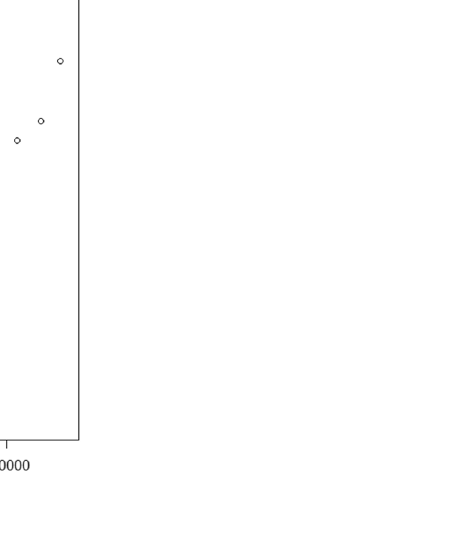
Figure 3. Mean excess plot for wildfires burned